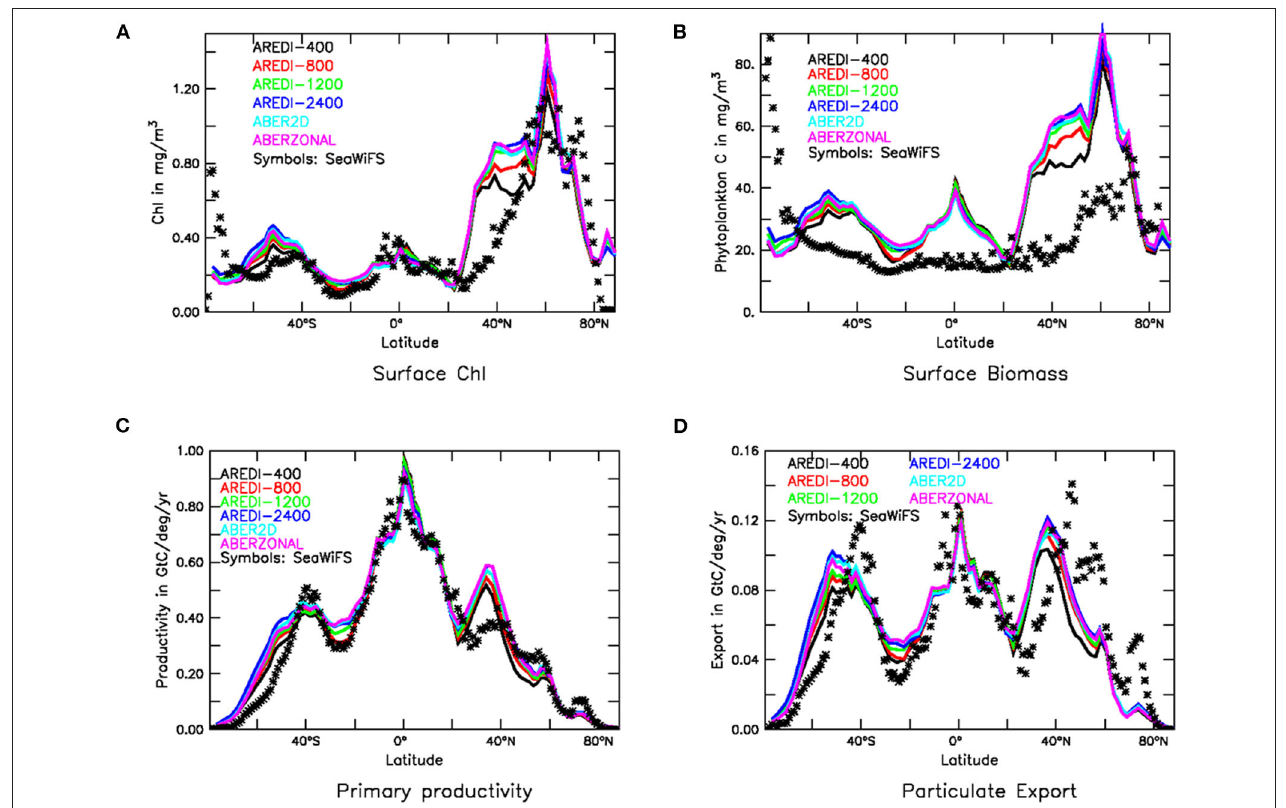
FIGURE 3 | Biological fields in CM2Mc pre-industrial control run with six different A REDI parameterizations (colored lines) compared with satellite-based estimates (symbols). (A) Zonally averaged chlorophyll (mg/m 3 ). (B) Zonally averaged particulate carbon (mg/m 3 ). (C) Zonally integrated primary production (GtC/yr/deg) and (D) Zonally integrated particle export across 100m (GtC/yr/deg). Satellite estimates in (A,C,D) are taken from Dunne et al. (2007). Particulate carbon in (B) is estimated from backscatter following Behrenfeld et al.